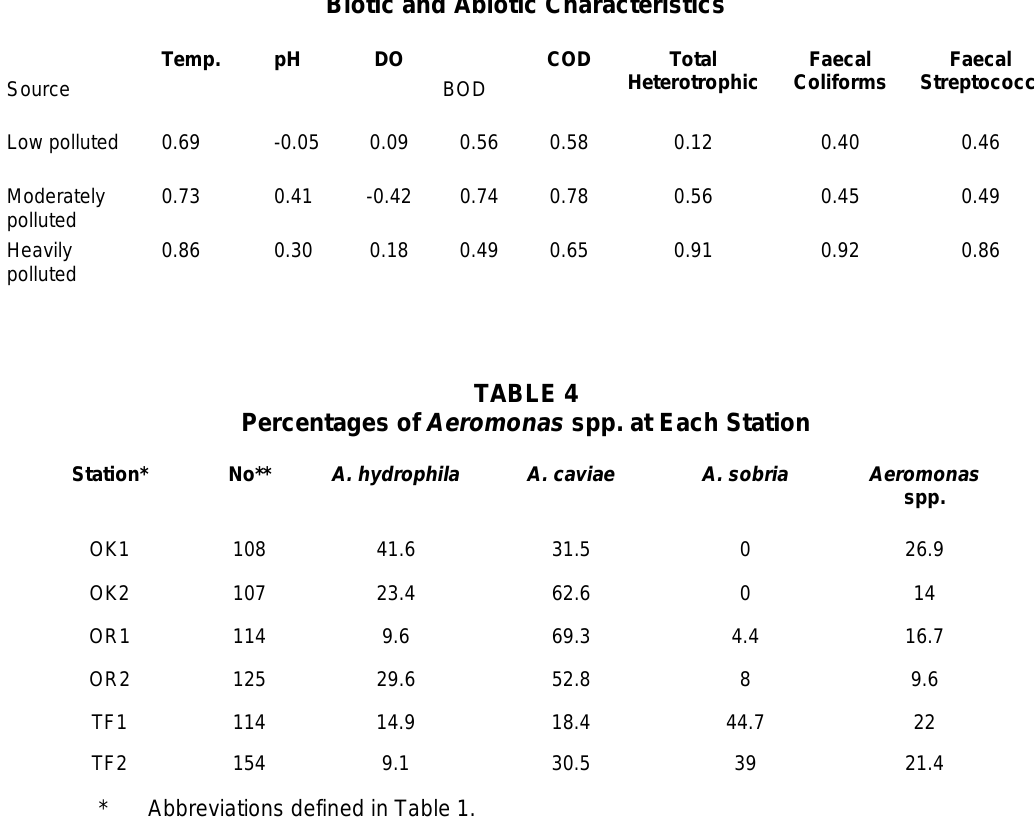
Percentages of Aeromonas spp. at Each